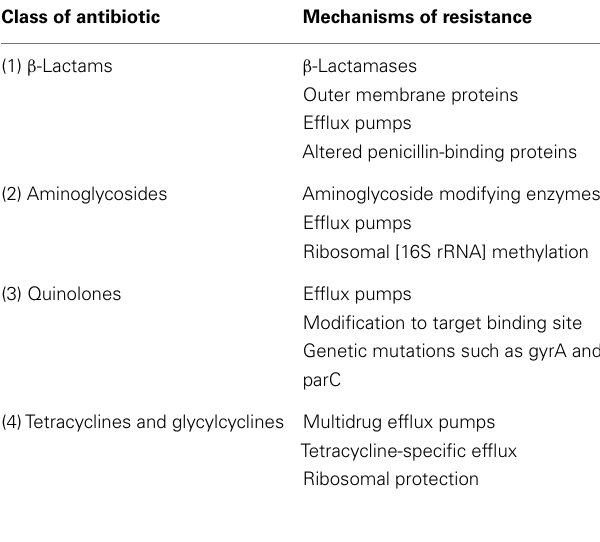
Table 2 | Mechanisms of A. baumannii drug resistance